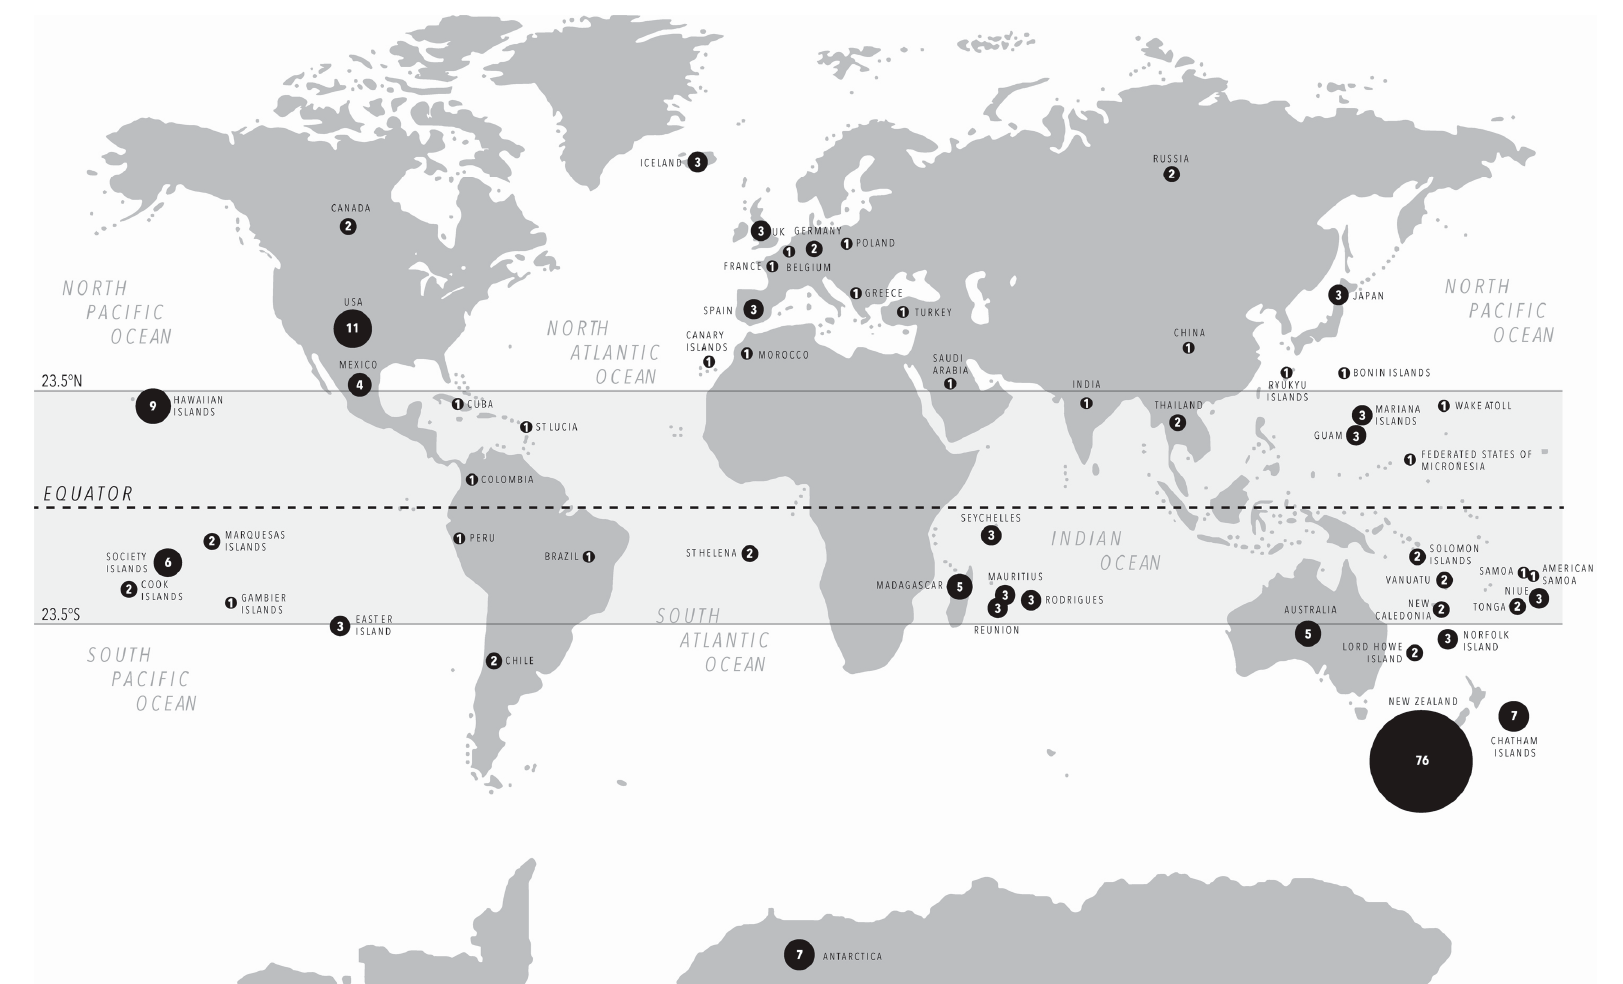
Figure 4. The distribution of the avian ancient DNA studies described in Table S1. The area of the circle is proportional to the number of studies undertaken using samples from that location. The central grey band represents the latitudes that are considered tropical.